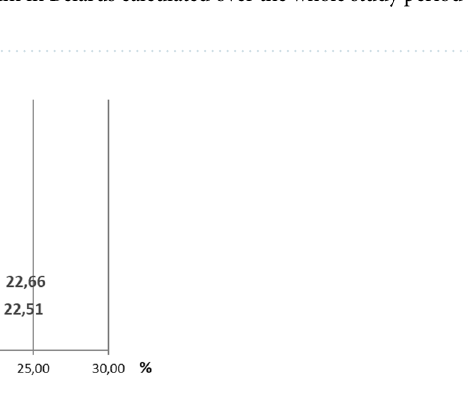
Figure 3. Proportion of B19V IgM positive patients by age group in Belarus between 2005 and